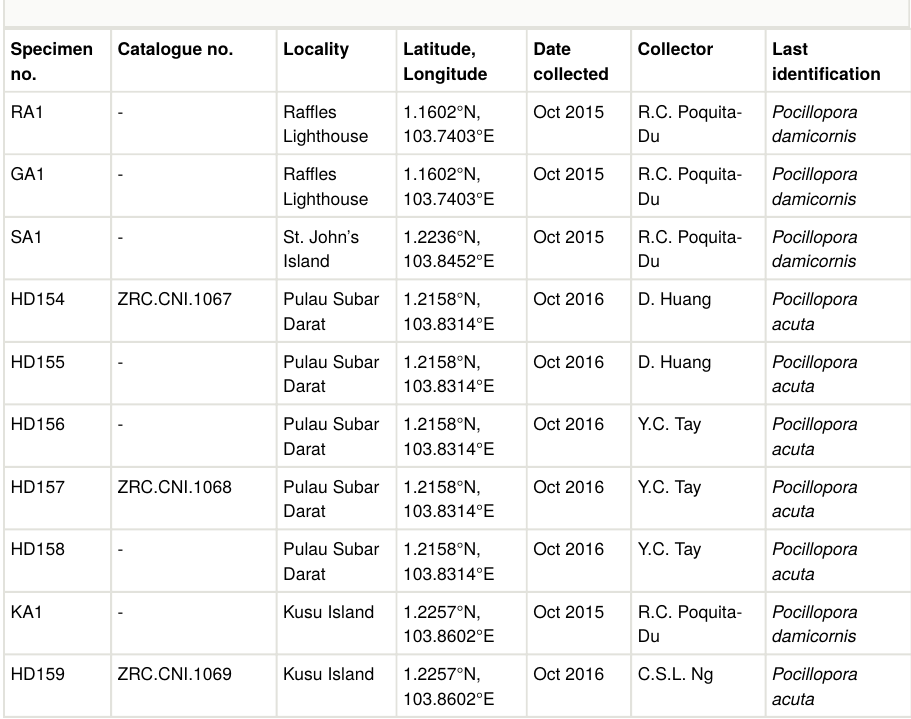
Table 1. Voucher specimens